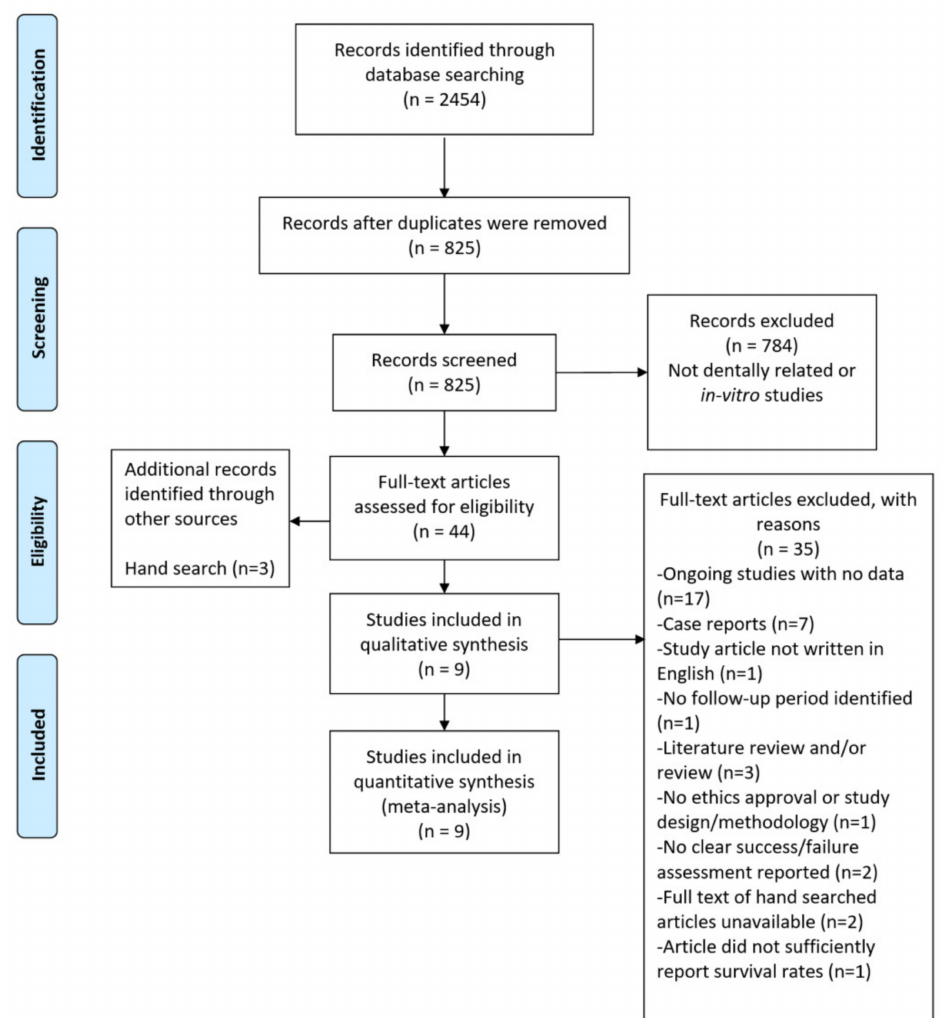
Figure 1. Flow diagram of the study selection